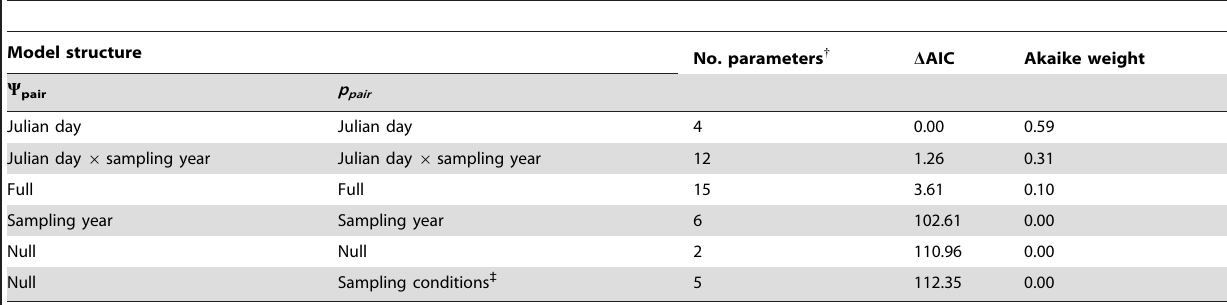
Table 5. Ranked two-state models of parental status ( Y pair ; according to Julian day and sampling year) and its detection probability (pair; according to sampling conditions) at pair level ( n =2331 adult songbirds).